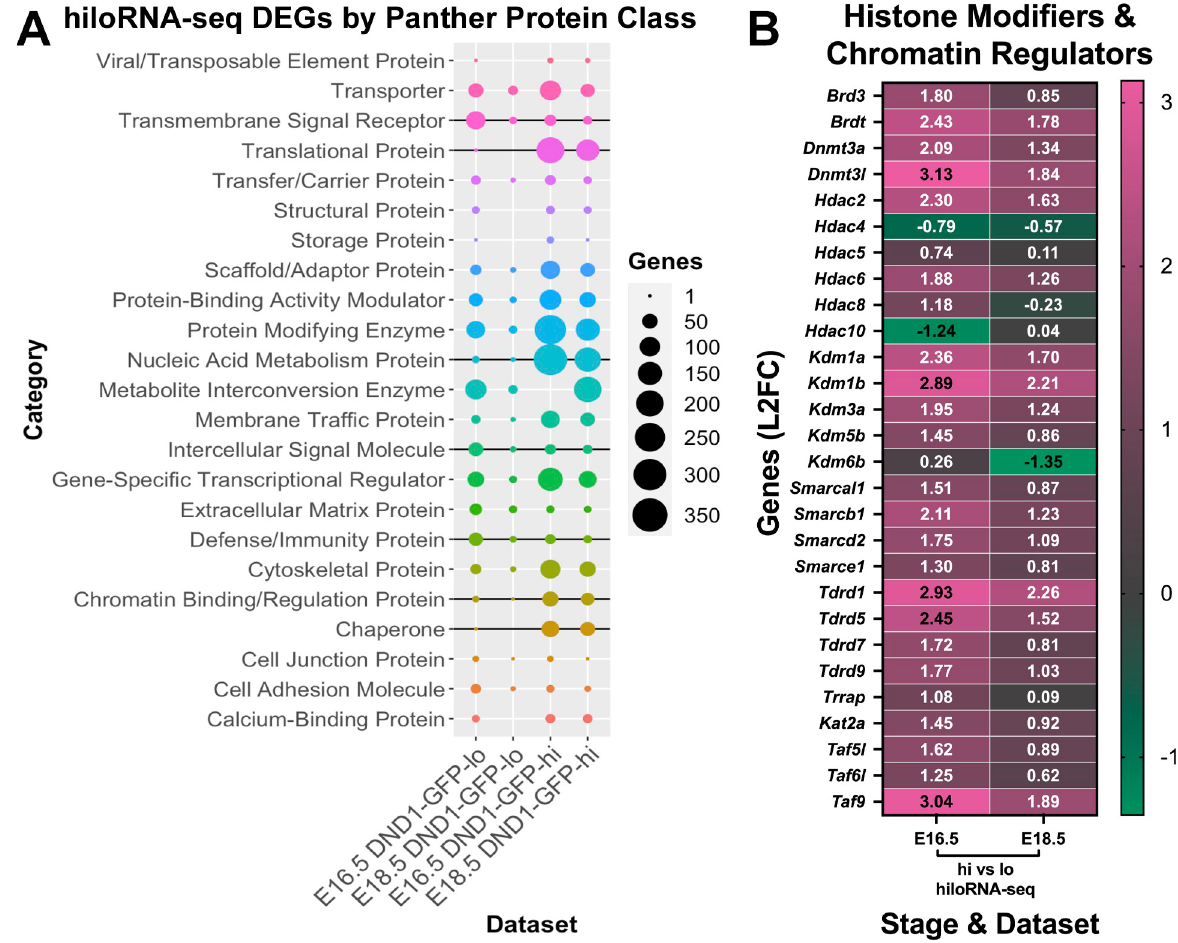
Fig 4. Expression of some protein class categories are significantly different in DND1-GFP-hi vs DND1-GFP-lo cells and consistent between E16.5 and E18.5. A: PANTHER analysis of significant differentially expressed genes in E16.5 and E18.5 DND1-GFP-lo cells, and E16.5 and E18.5 DND1-GFP-hi cells. Results displayed as protein class categories by dataset and graphed with the number of genes in each category corresponding to the size of the circle. Protein classes distinguishing DND1-GFP-lo cells at both stages include “Defense and Immunity”, “Transmembrane Signal Receptor” and “Intercellular Signal Molecule” (noted with black vertical line). Protein classes distinguishing DND1-GFP-hi cells at both stages include “Chaperone”, “Chromatin Binding/Regulation”, “Nucleic Acid Metabolism”, and “Translational” (noted with black vertical line). B: Heat map of chromatin / epigenetic regulators showing: L2FC in DND1-GFP-hi vs DND1-GFP-lo cells from hiloRNA-seq (E16.5, E18.5).